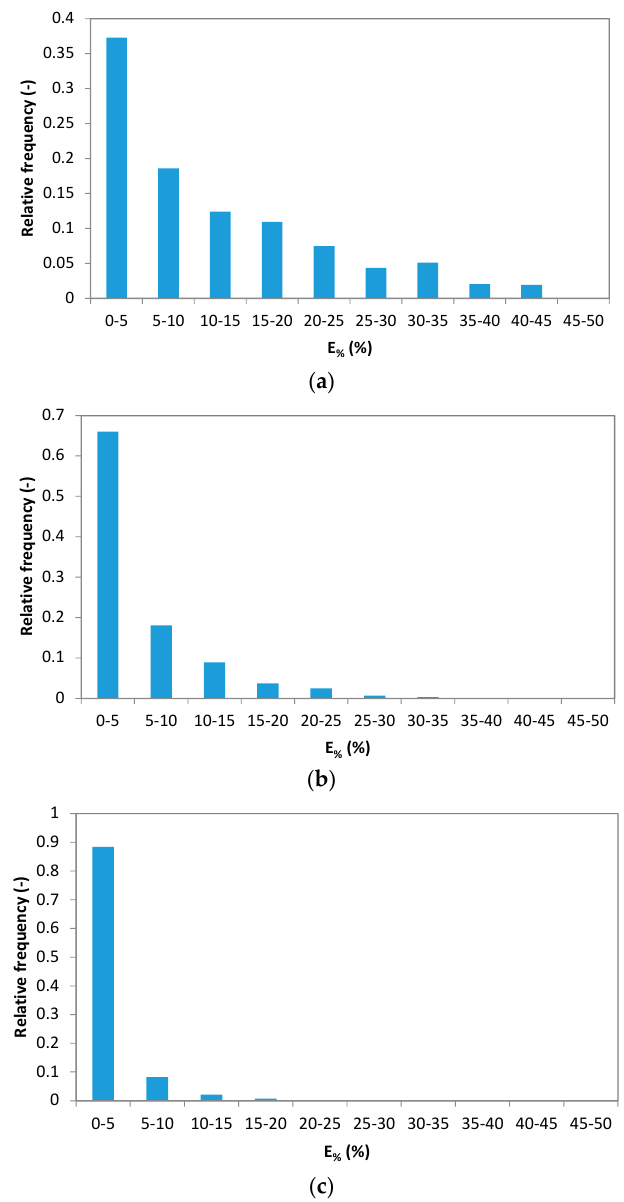
Figure 4. Relative frequency of the underestimation error, E % , of the maximum rainfall depths considering classes amplitude equal to 5%. ( a ) t a / d = 1. ( b ) t a / d = 0.5. ( c ) t a / d = 0.333. All selected rain gauge stations and all possible combinations of t a and d were considered.